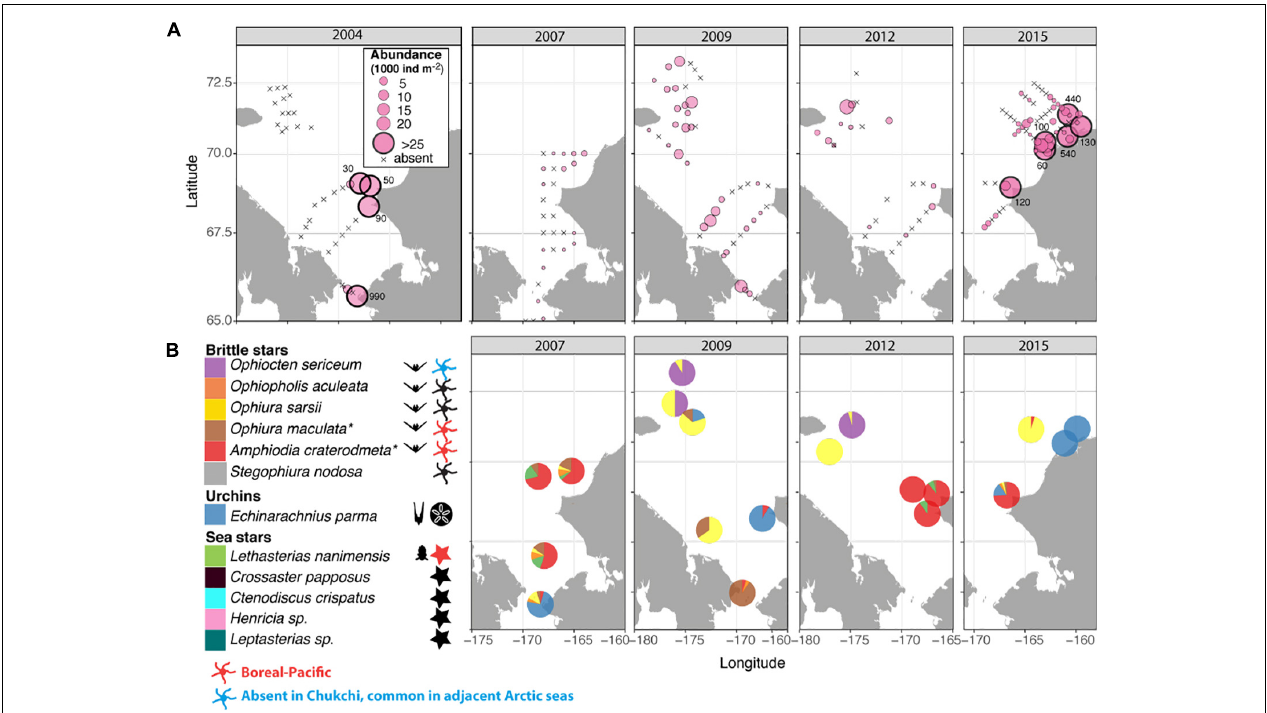
FIGURE 7 | (A) Distribution and abundance (1000 ind m − 2 ) of echinoderm larvae during the sampling years 2004, 2007, 2009, 2012, and 2015; numbers outside large symbols ( > 25) indicate values at these stations (B) Taxonomic composition of echinoderm larvae; colors indicate relative species abundances; Symbols to the right of the taxonomic legend indicate the presence of taxa in the Chukchi Sea as planktonic larvae, adults, or both, with red indicating boreal-Pacific species occasionally observed in the Southern Chukchi and blue indicating Arctic species not found in the Chukchi, but common in adjacent Arctic seas. ∗ – presumed species, see Results section for